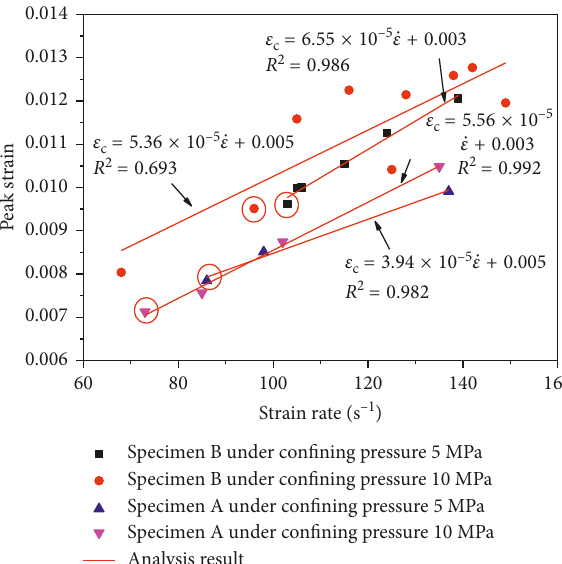
Figure 7: Variation in peak strain with strain rate.